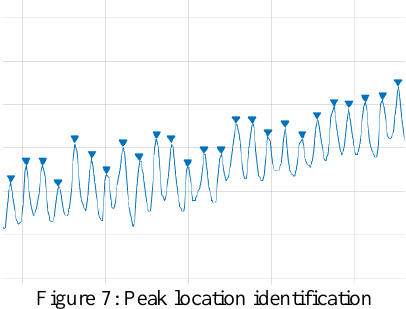
Figure 7: Peak location